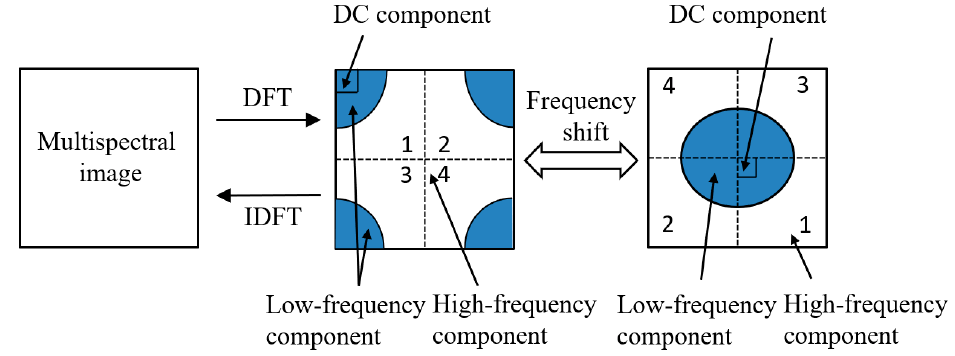
Figure 13. Two-dimensional Fourier-transform frequency component distribution diagram.